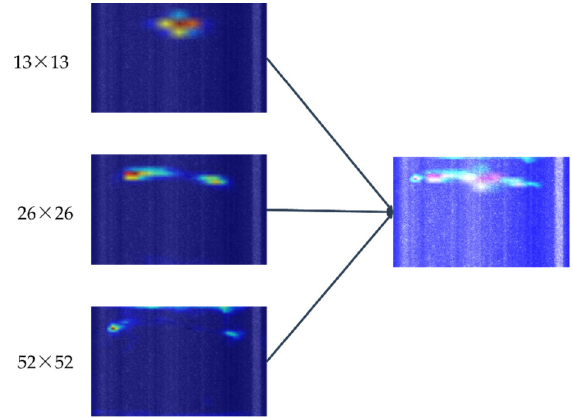
Figure 11. The three output feature layers ( left ); visualized feature maps after superimposition ( right ).